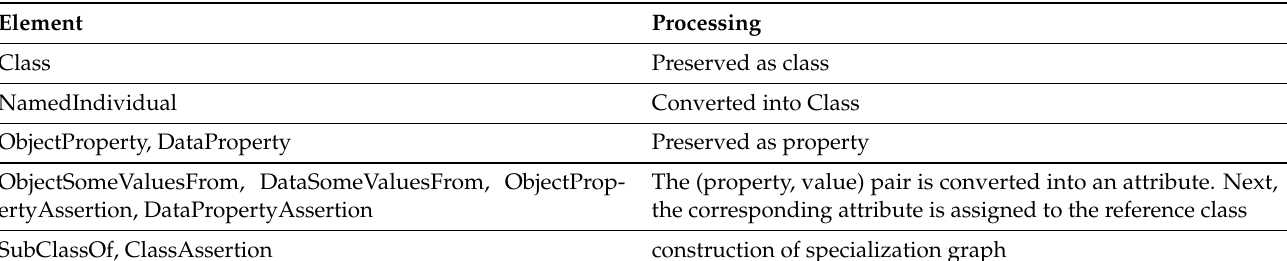
Table 5. Transformation rules used in the evaluation